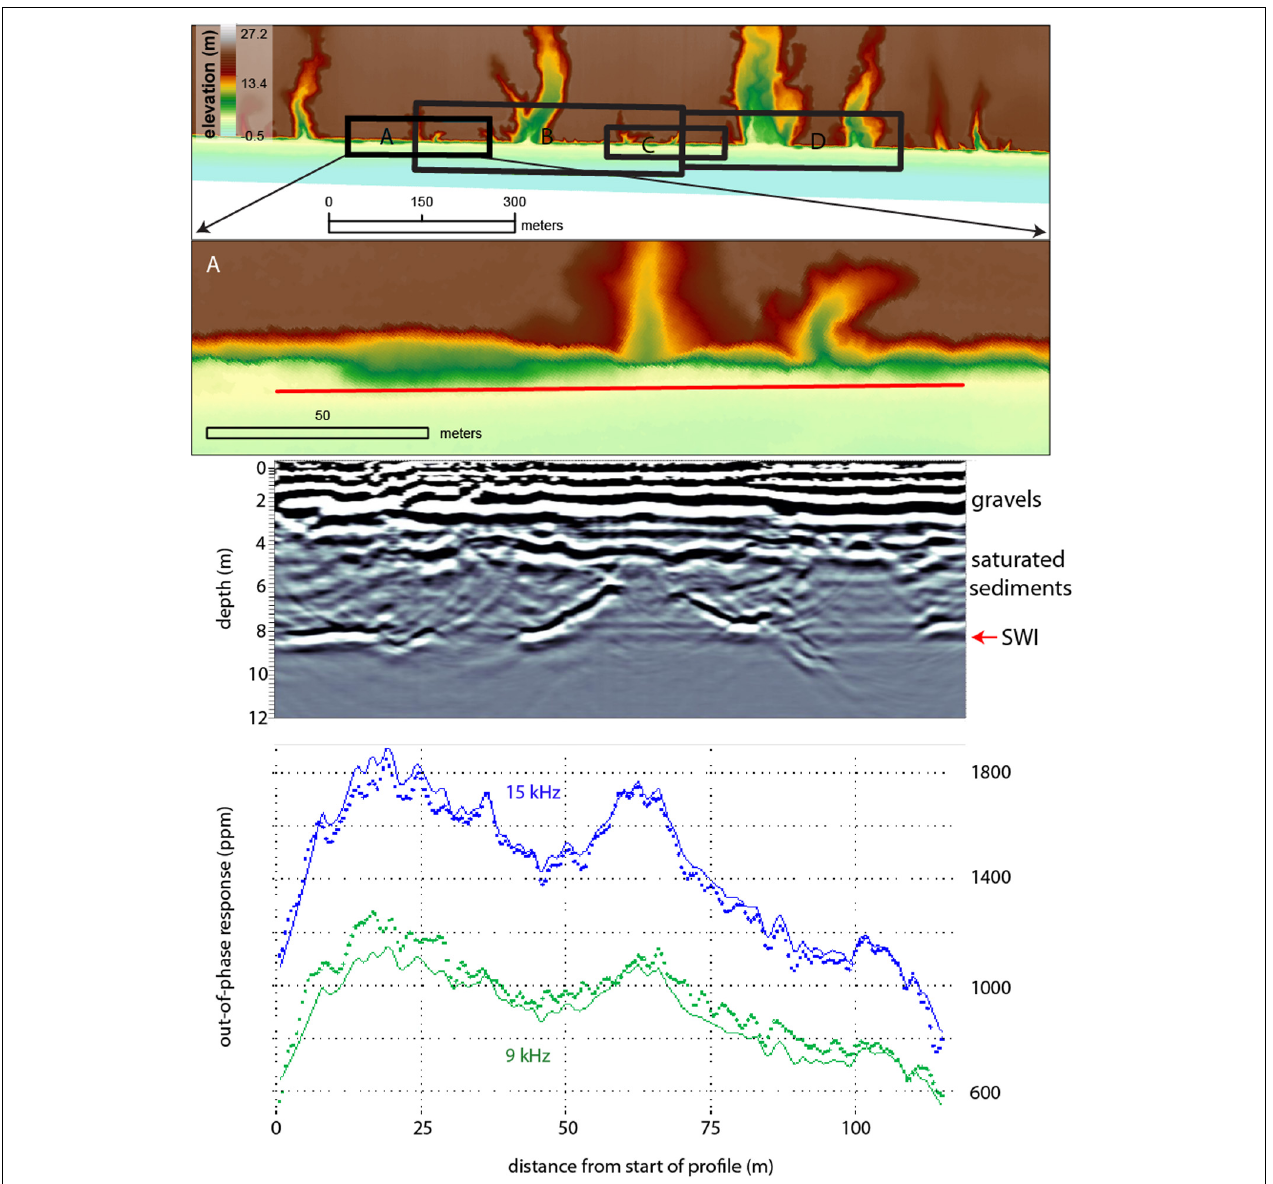
FIGURE 6 | Collocated alongshore GPR and EMI surveys indicated by the red line on each DEM shown in Figures 6–9 . Each depth-converted radar section is shown in the middle panel. Measured EMI data (bottom panel) are indicated by the blue and green dots while the solid lines are the fitted data from the 1D inversion. In each figure the freshwater–seawater reflector is denoted by the red arrow marked SWI (saltwater interface) and the approximate depths of the interpreted gravels and saturated sediments are labeled on the right hand side of the GPR